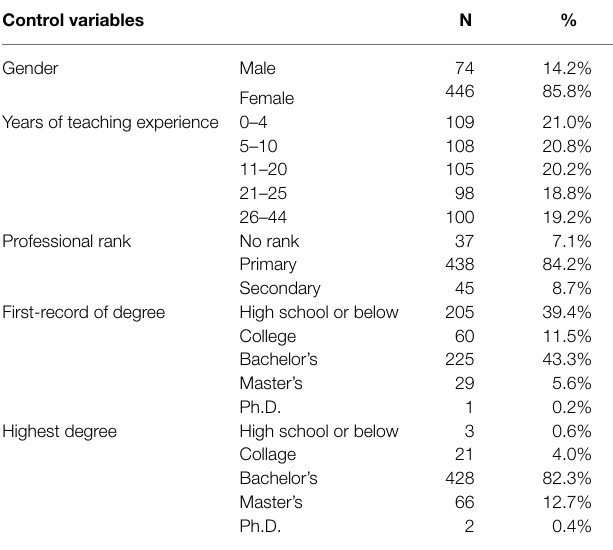
TABLE 1 | Distribution of gender, years of teaching experience, professional rank, and educational background ( n = 520). Control